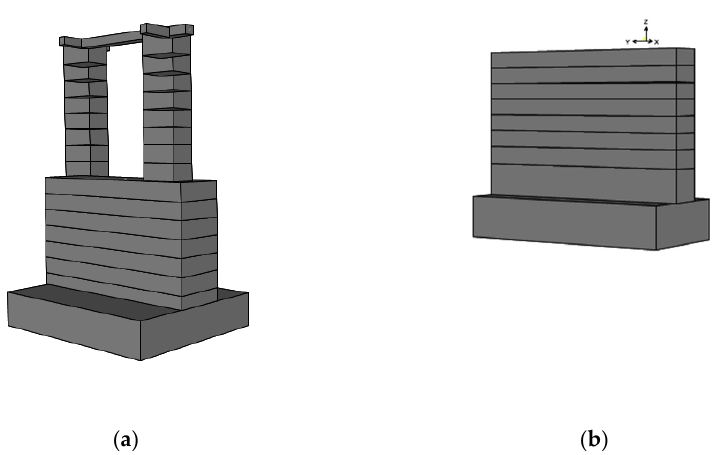
Figure 5. Finite element model of double-deck bridge.